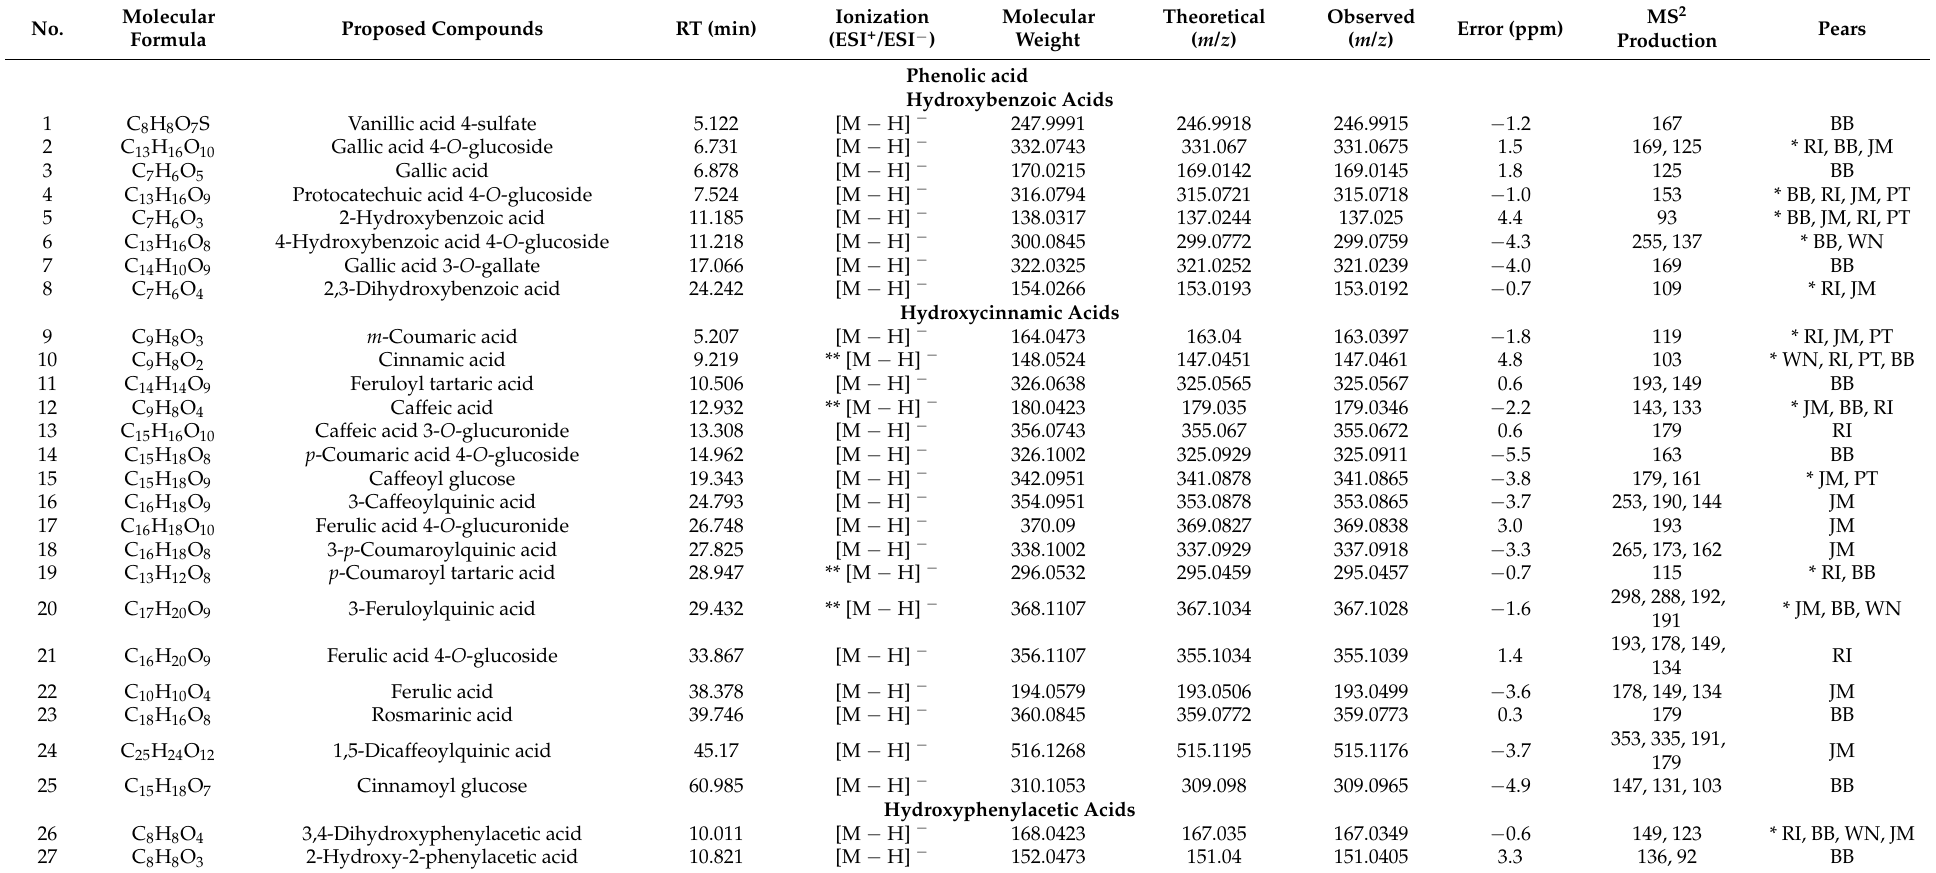
Table 3. Characterization of phenolic compounds in different pear samples by liquid chromatography coupled with electrospray-ionization quadrupole time-of-flight mass spectrometry